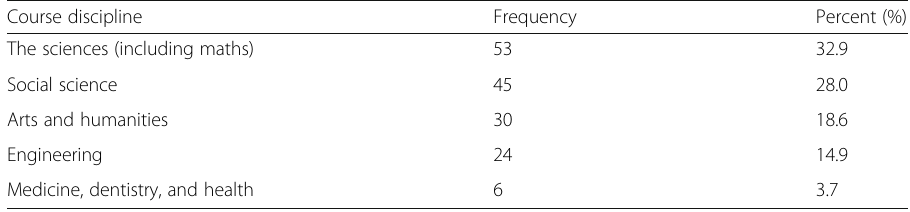
Table 2 Frequencies and percentages of course discipline of students in the